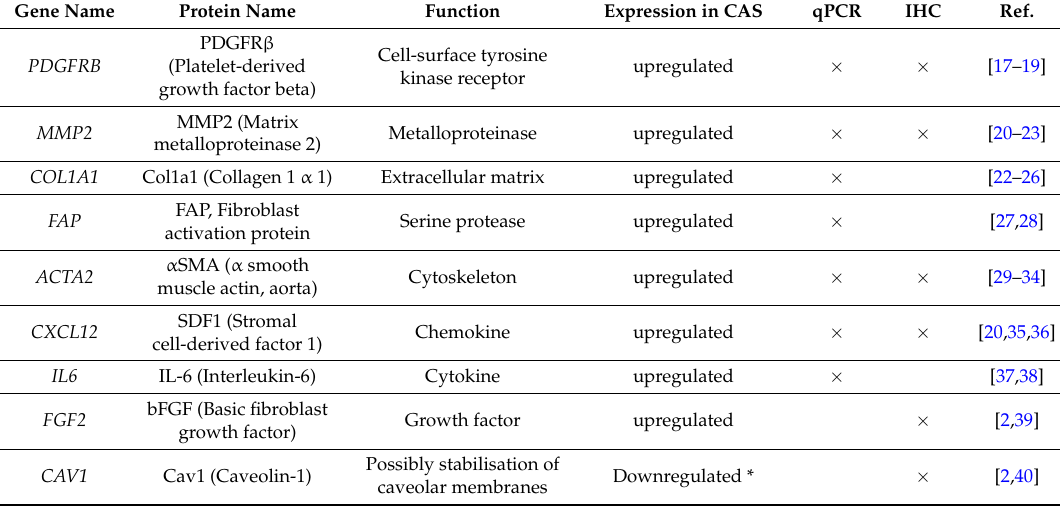
Table 2. List of the cancer-associated stromal targets selected for analysis in this study. List of gene names and their respective protein names that were assessed by RT-qPCR (Reverse Transcription quantitative PCR), immunohisto–chemistry, or both. “Expression in CAS” summarises the expression trend as observed in human studies (see References). The column “qPCR” denotes which of